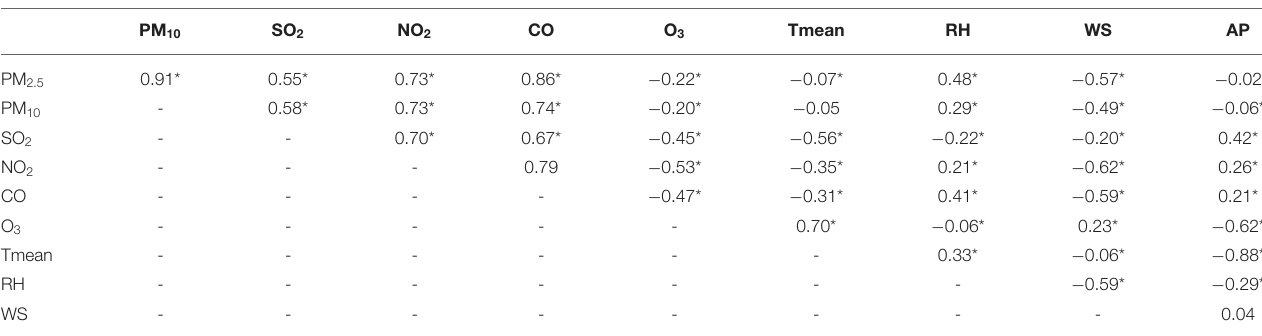
TABLE 3 | Spearman’s correlations between air pollutants and meteorological